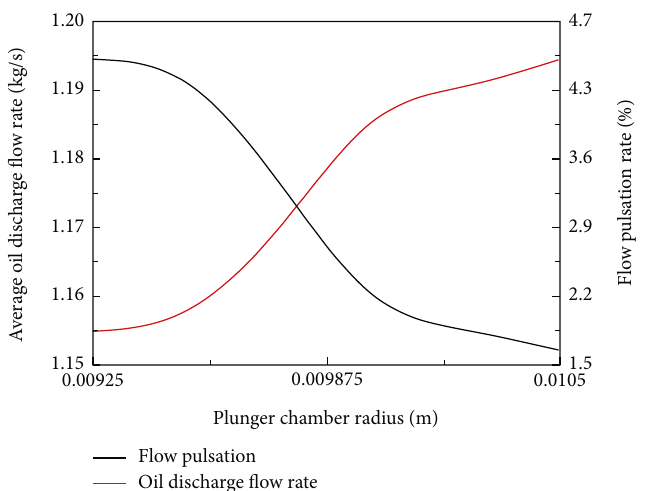
Figure 20: The average oil discharge fl ow rate carve and fl ow pulsation rate curve with di ff erent plunger chamber radii and rotation